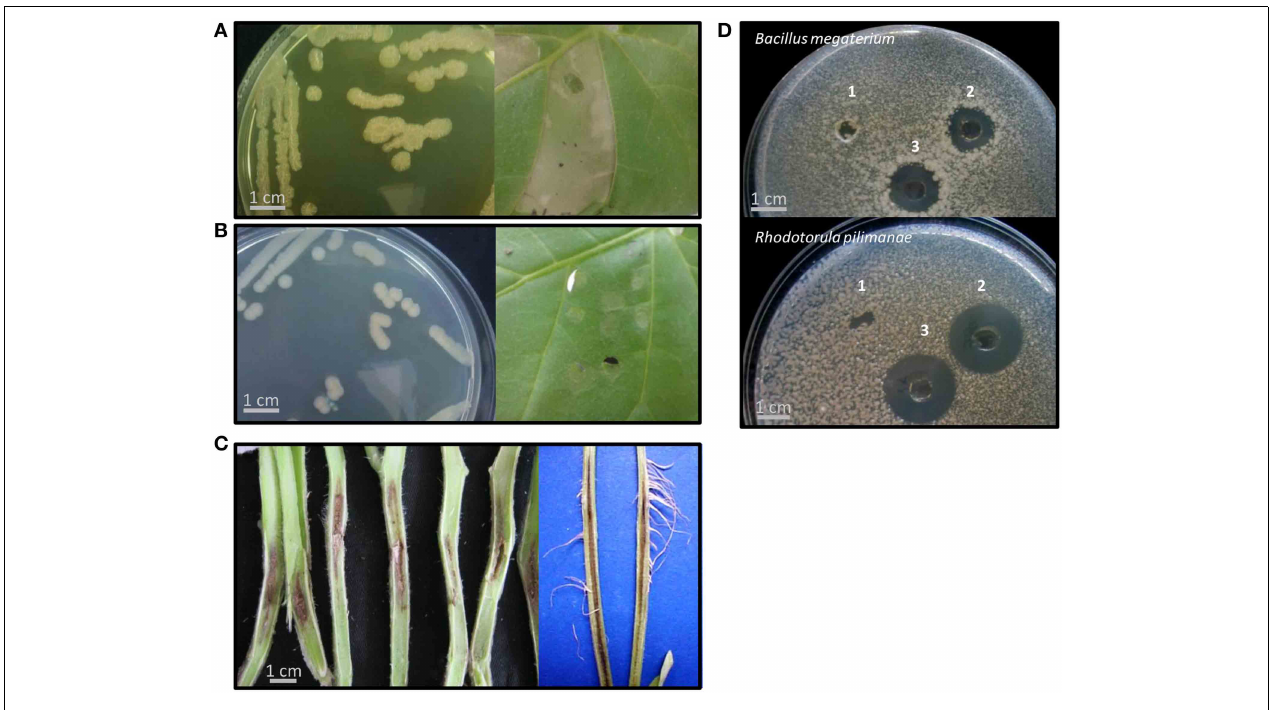
FIGURE 1 | Representative phenotypes of Pseudomonas corrugata ( Pcor ) and P. mediterranea ( Pmed ) strains in this study. (A,B) Strains showed either a rough colony morphology with production of a yellow diffusible pigment in the medium (R-phenotype) or smooth colonies that did not produce pigment (S-phenotype). All “R” strains induced a hypersensitive-like response (HR) in Nicotiana benthamiana ( Pcor CFBP5454 in A ) while the “S” strains Pcor TEIC1148 and Pmed CFBP5444 (the latter in B ) did not induce HR. (C) All strains were able to